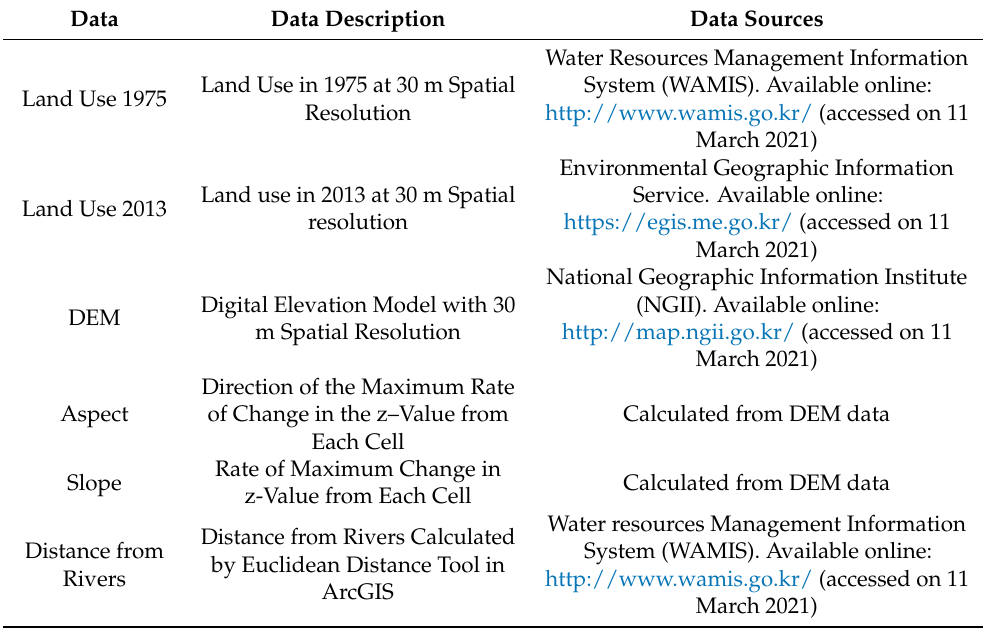
Table 1. List of data used in future land use simulation (FLUS) and data sources. DEM, digital elevation